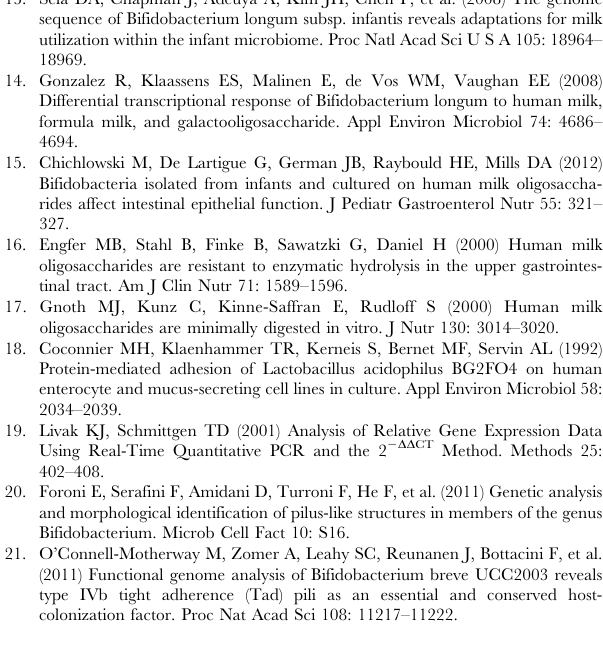
Figure S1 Screening oligosaccharides for their ability to influence adhesion of B. longum subsp. infantis ATCC Figure S2 Boxplot analysis of the pool of genes up- regulated by the mixture of 3 9 - and 6 9 -sialyllactose. Common = those genes upregulated by all treatments, [3 9 SL] &